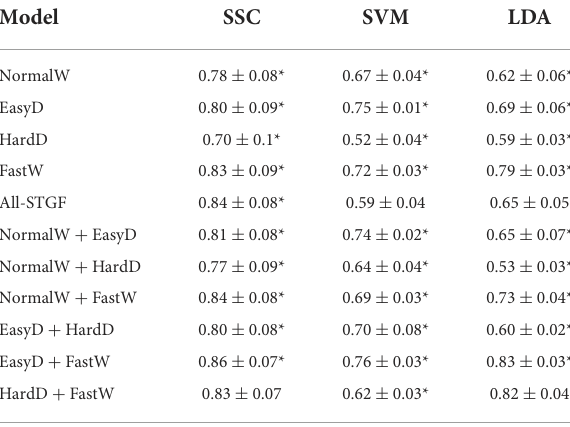
TABLE 2 AUC values for the three classifiers using the eleven models for HE and MCI-E